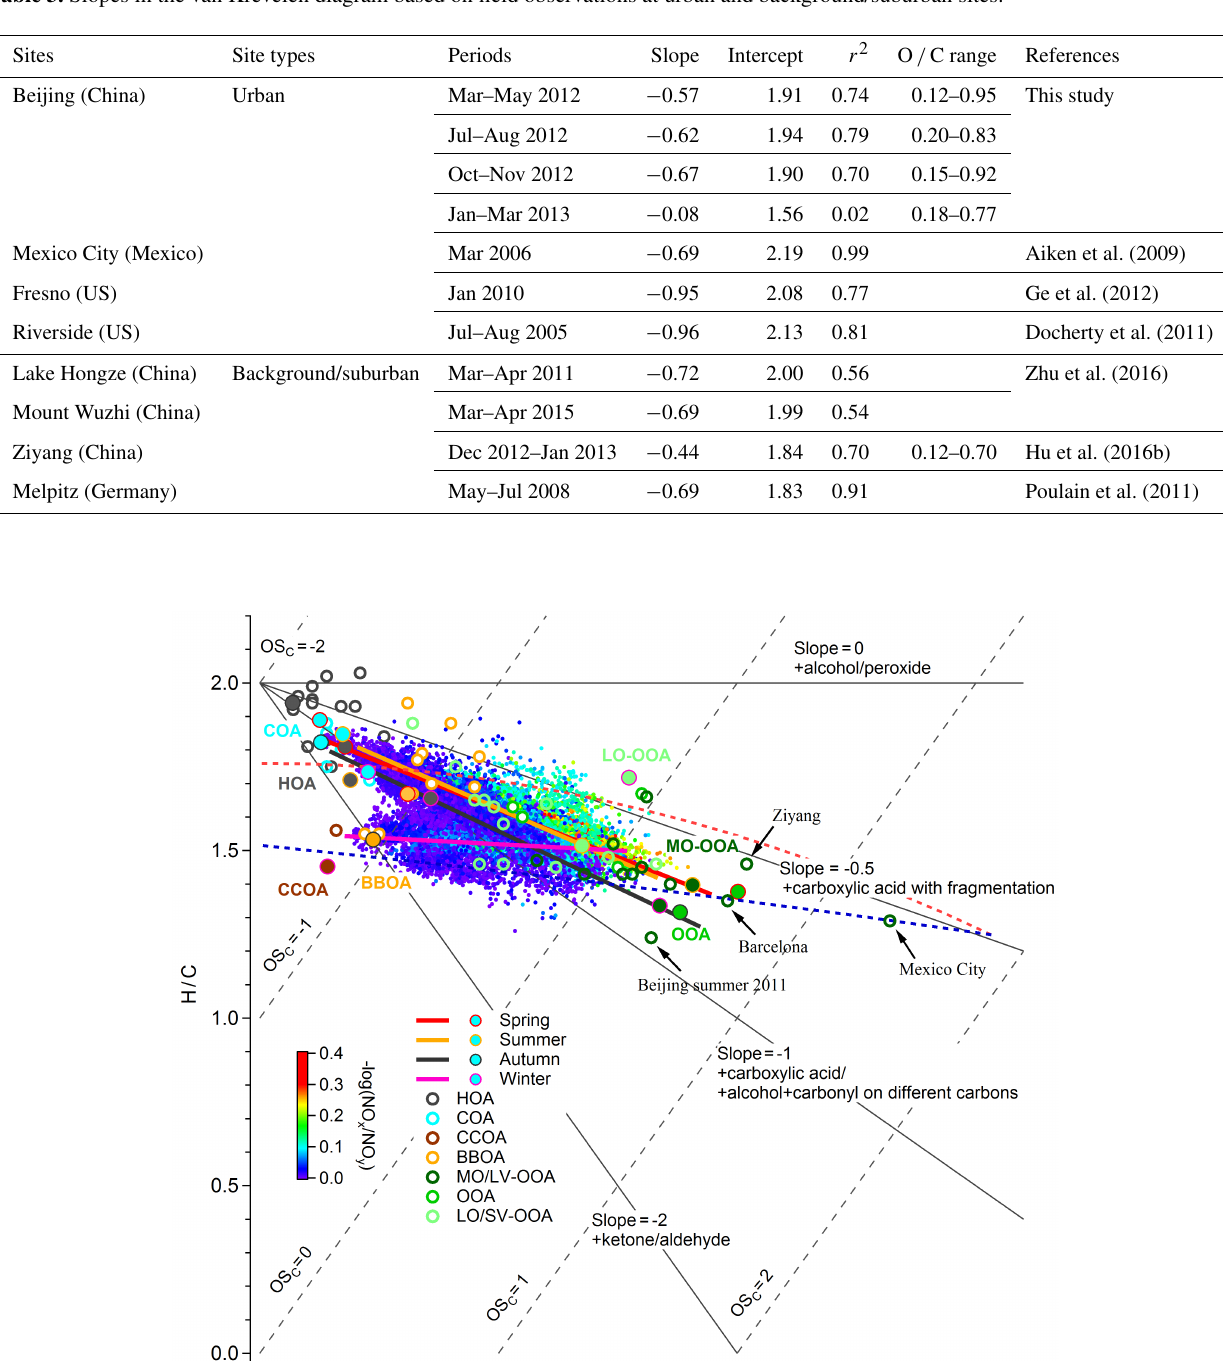
Table 3. Slopes in the van Krevelen diagram based on field observations at urban and background/suburban sites.